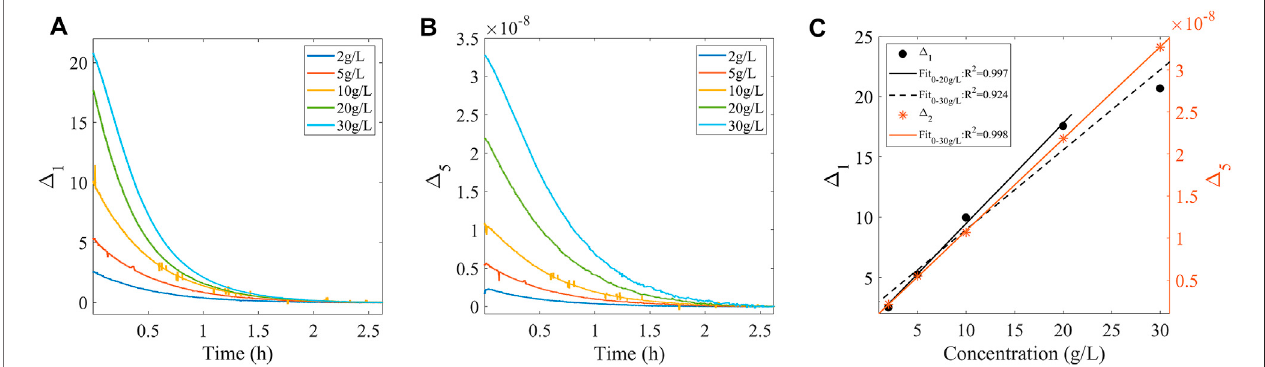
FIGURE4|(A,B) CharacterizationresultsofthehydrolysisprocessofsucroseforMethodsAandE,respectively. (C) Linear fi tofthetwocharacterizationmethods corresponding to the amount of change in the hydrolysis process for different concentrations of the sucrose solutions.